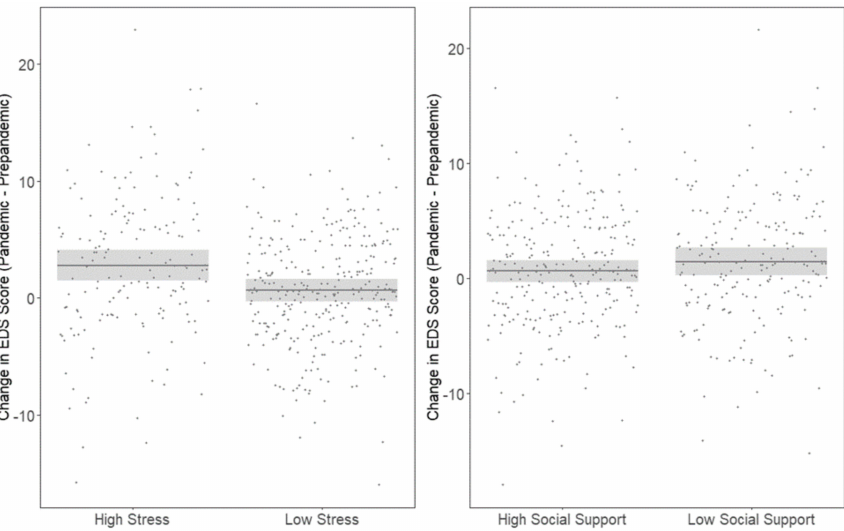
Figure 1. Association between change in EDS score, stress and social support during the pandemic. Model adjusted for NLE and social support score at baseline and during the pandemic, SES at baseline and age during